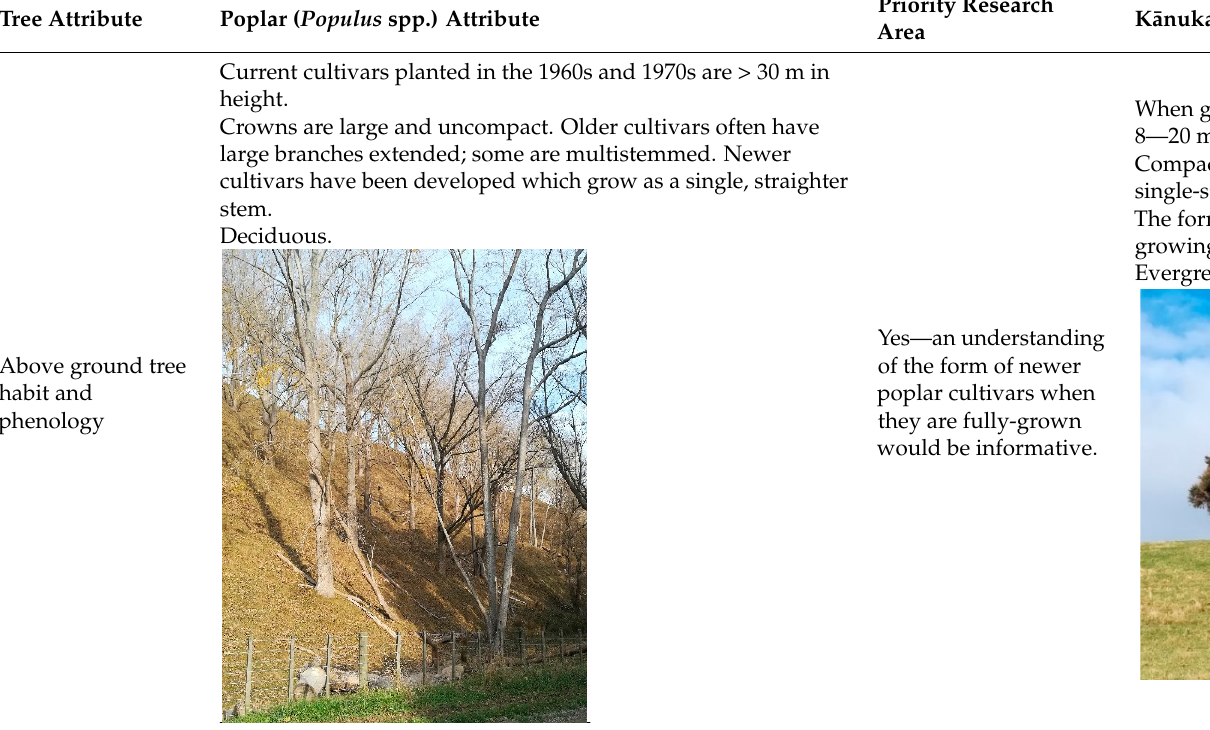
Table 2. Tree attributes for poplar ( Populus spp.) and k ā nuka ( Kunzea spp.) in a New Zealand hill country silvopastoral system. Tree attributes have been adapted from Wood [15]. The photographs were taken by the lead author. Tree Attribute